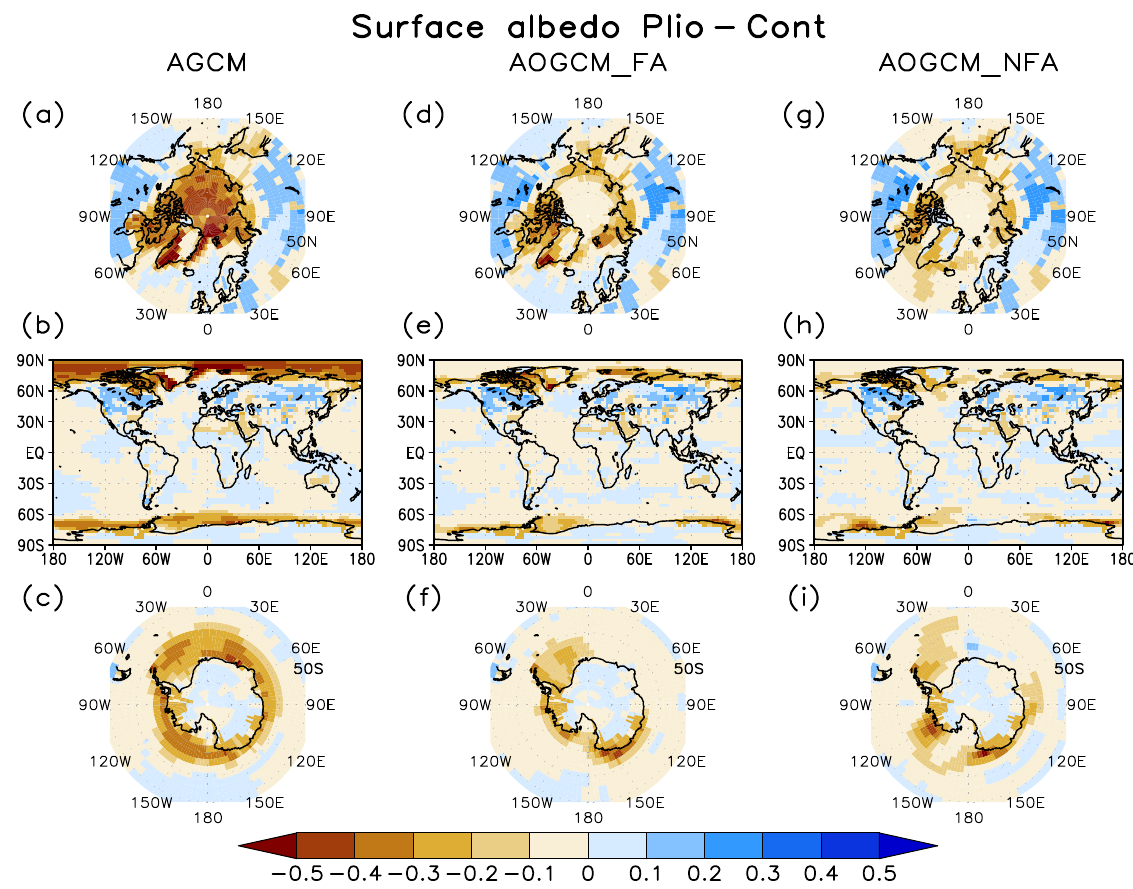
Fig. 6. Difference of surface albedo between Pliocene and Control in (a, b, c) AGCM, (d, e, f) AOGCM_FA, (g, h, i) AOGCM_NFA. 4